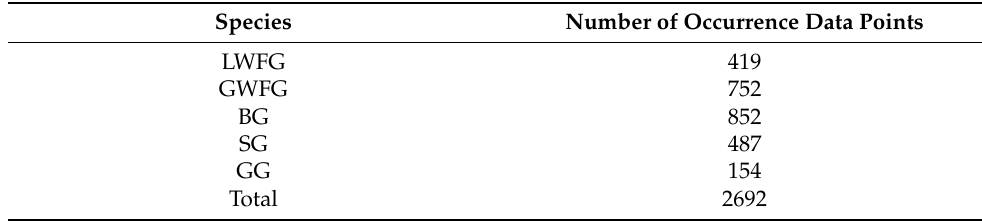
Table 1. Number of occurrence data points for five species of geese (lesser white-fronted goose (LWFG), greater white-fronted goose (GWFG), bean goose (BG), swan goose (SG), and greylag goose